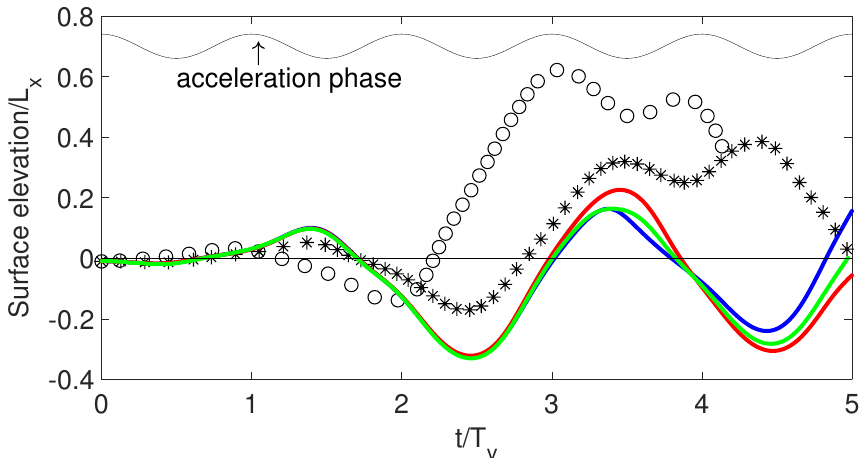
Figure 4. Comparison of different approaches in the nonlinear regime: surface elevation at the midpoint-inverted acceleration phase. (o) Wright et al. [7], (*) PF S [15], (–) EbFVM S (this work), (–) FT S (this work), (–) VOF S (this work).